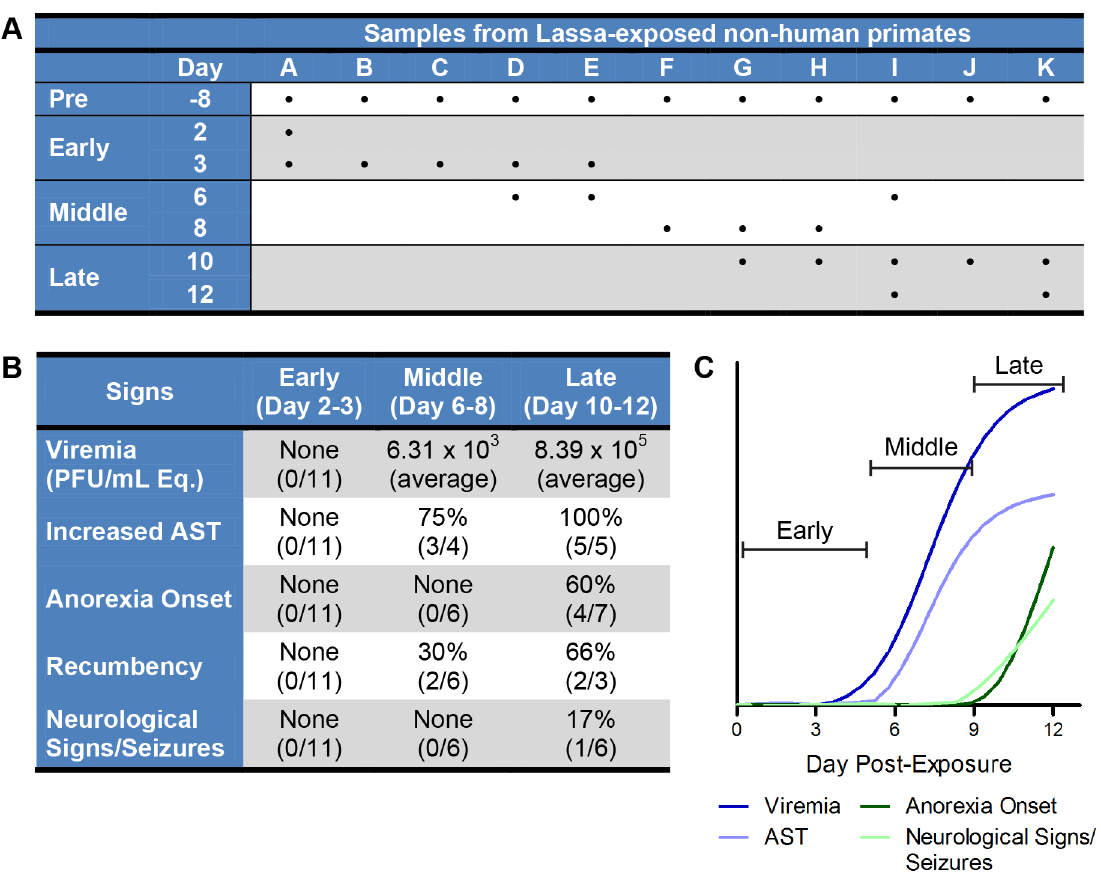
Figure 1. Confirmation of LASV aerosol model. (A) Overview of the sequential sampling study samples. The table is organized by animal (column, represented with letter A–K) and day that the sample was collected (row). Samples from LASV-exposed NHP were sorted temporally by the day the sample was collected post-exposure, and further divided into three general categories (early, middle, and late induction) to ease interpretation. Pre-exposure samples were collected prior to LASV exposure and used to normalize data obtained from subsequent samples from the same animal. (B) Table describes the time of onset (early, middle, and late) of a given symptom (viremia, increased AST, anorexia onset, recumbency, and neurological signs/seizures) post-LASV exposure. Data is presented as the number and percentage of animals in which a clinical finding was detected, followed by the total number of animals that were examined at a given stage. (C) A conceptual diagram to explain the division of early, middle, and late stages of LASV in our sequential sampling NHP model. Early disease stage (0–5 dpe) is asymptomatic; middle disease stage (6–9 dpe) is early symptomatic with increase in viremia (dark blue line) and AST levels (light blue line); late disease stage (10–12 dpe) is depicting increasing signs of disease with increase in the onset of anorexia (dark green line) and neurological signs/seizures (light green line) in